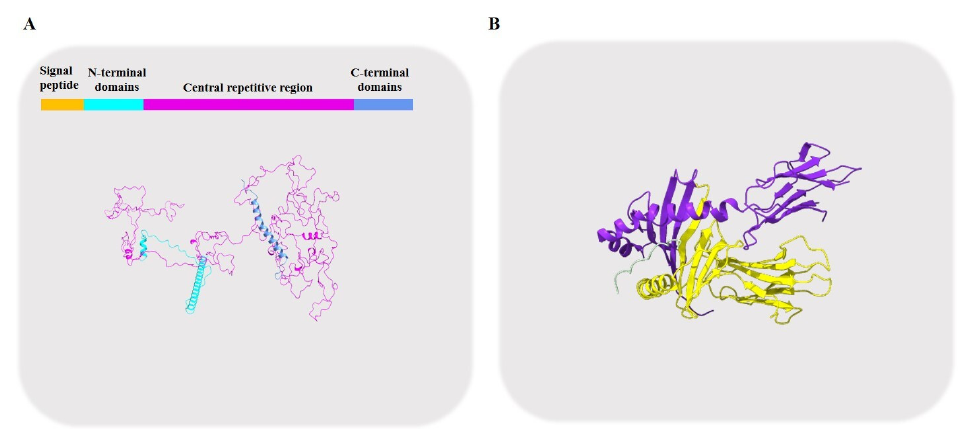
Figure 2. Structure of glutenins. ( A ) Predicted structure of HMW-GS; ( B ) Crystal structure of LMW- GS (PDB: 6px6). The yellow and purple colors show two subunits of LMW-GS.